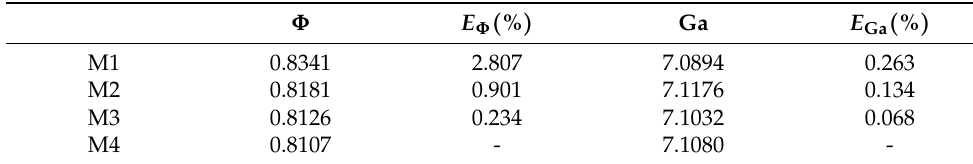
Table 9. Mesh sensitivity study results for 3D rising bubble C1 case. Absolute error E has as reference value that of the M4 mesh.